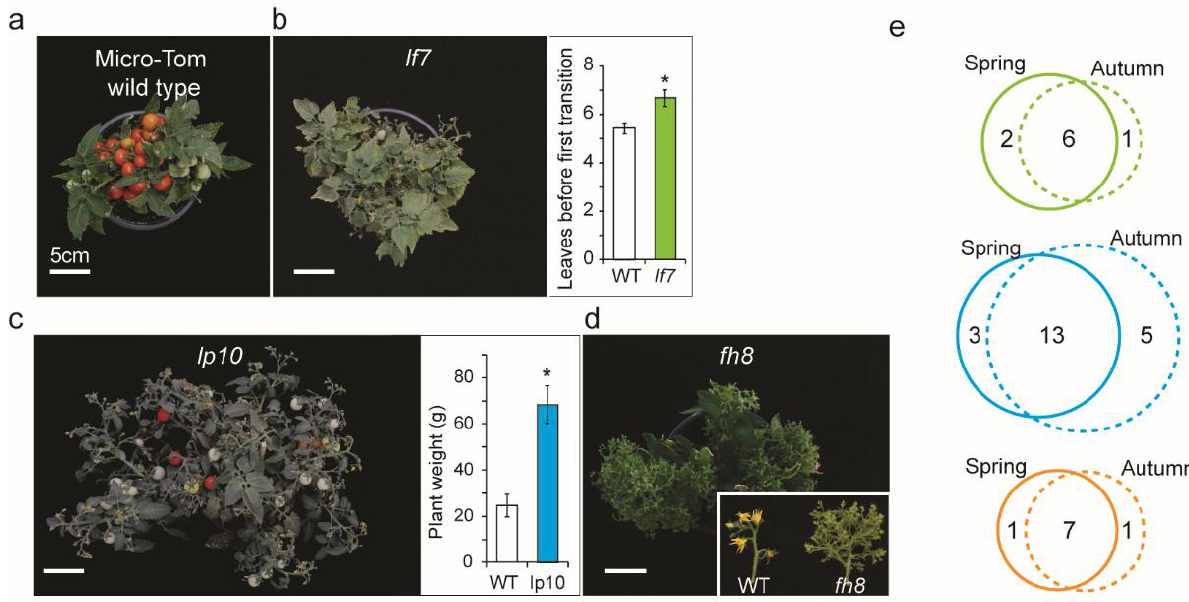
Figure 2. Flowering time variants showing lf , lp , and fh mutants. ( a – d ) Representative plant growth showing Micro-Tom as wild type ( a ), late-flowering plant growth of lf 7 ( b , left ) with the comparative graph for leaves produced by the primary shoot meristem (PSM) with Micro-Tom ( b , right ), large plant growth of lp10 ( c , left ) with the comparative graph for plant weight with Micro-Tom ( c , right ), and floral homeotic phenotype of fh8 with the comparative image of inflorescences with Micro-Tom ( d ). ( e ) Venn diagrams showing the number of mutant lines producing more than 6 leaves by PSM in spring and autumn experiments. Colored solid-line circles indicate the spring experiment. Colored dashed-line circles indicate the autumn experiment. Three mutant groups categorized as lf (green line circles), lp (blue line circles), and fh mutants (orange line circles) *, p < Table 1. Flowering time is associated with three phenotypic groups categorized with late-flowering, large plant, and floral homeotic phenotypes.